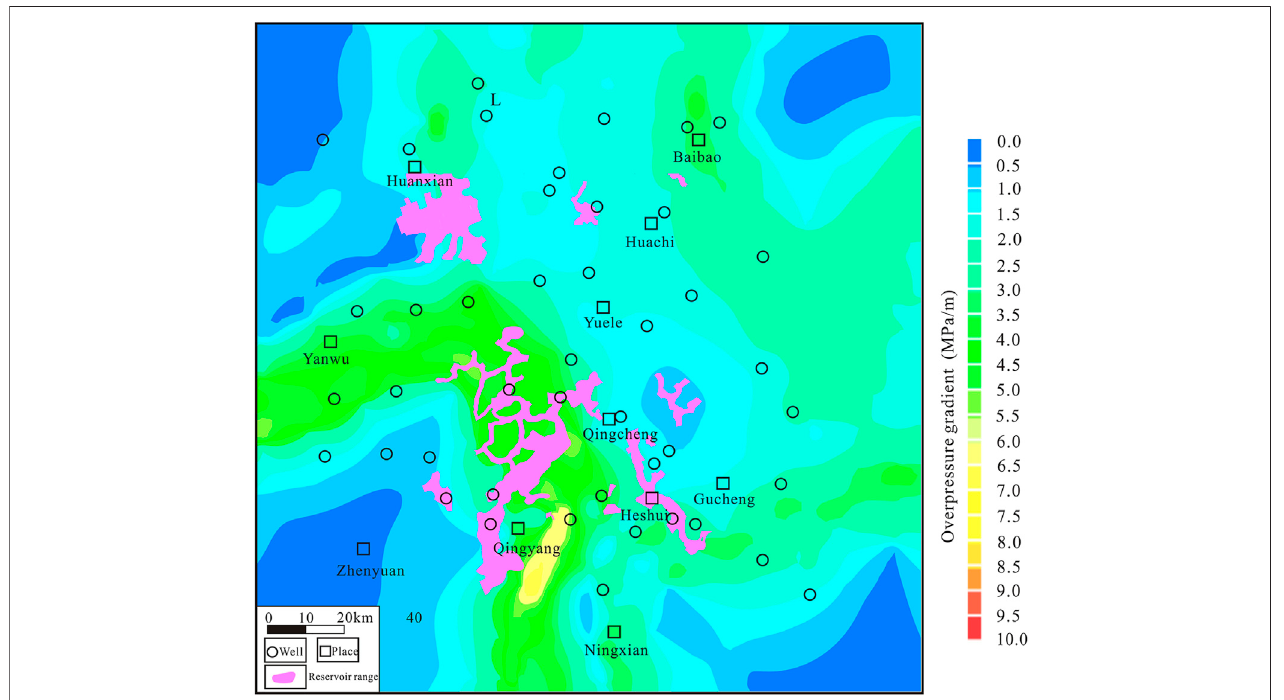
FIGURE 8 | Distribution of the overpressure gradient of the Chang 8 member during the main reservoir-forming period in the Longdong area.